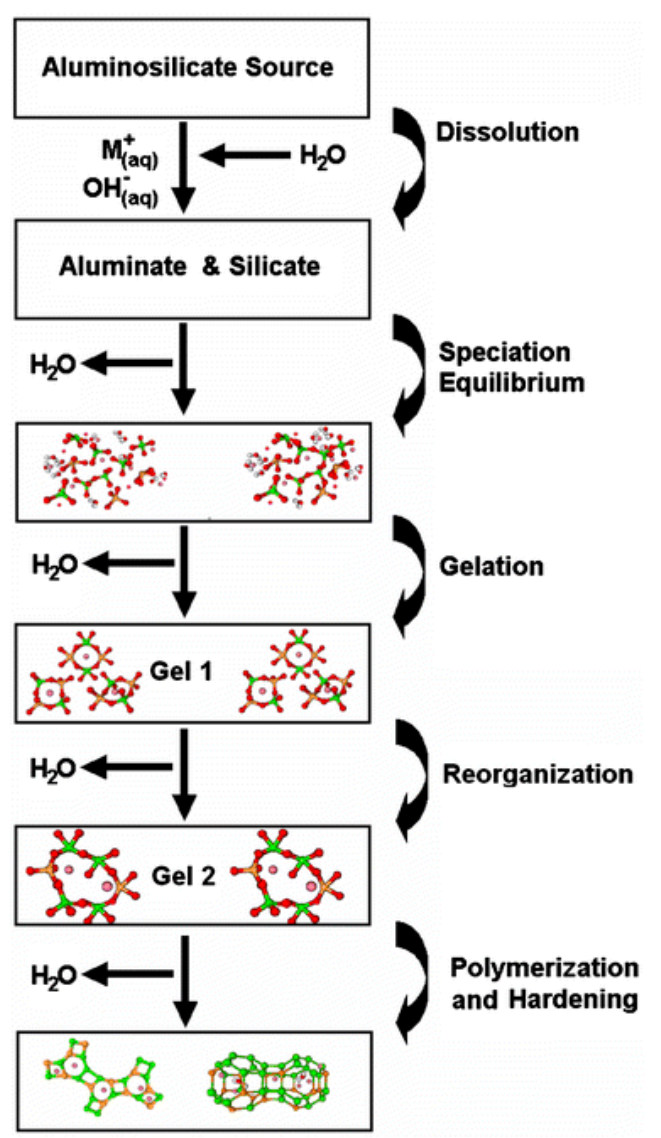
Figure 8. Geopolymerization process [98].